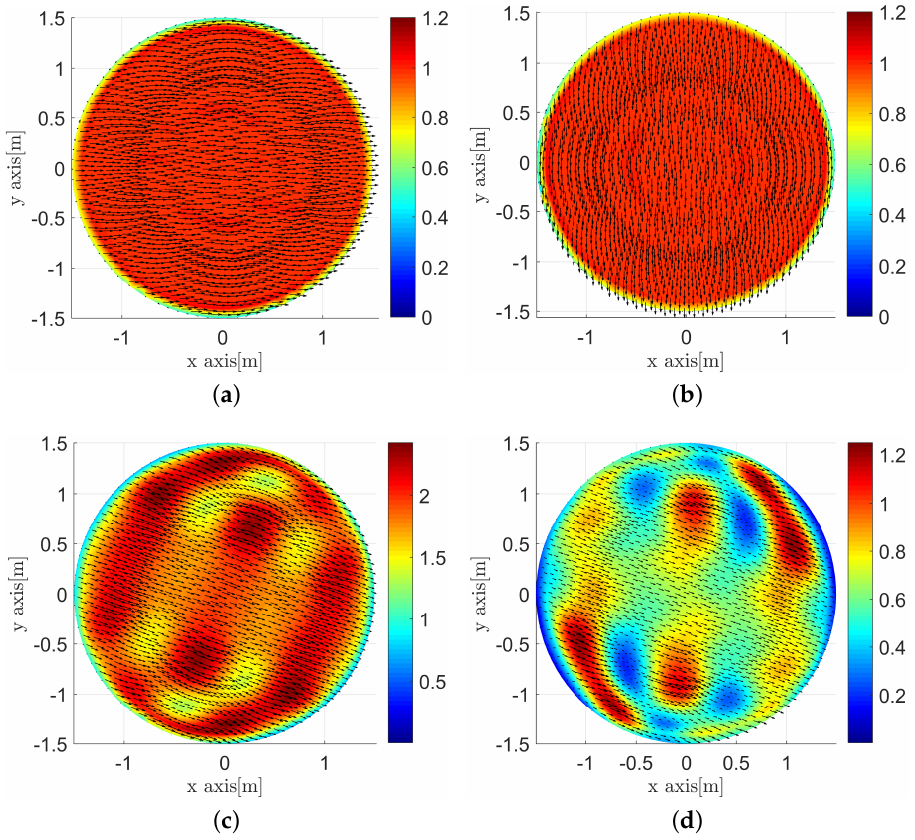
Figure 4. Surface current distributions of the SHDB disk shown in Figure 1 at the frequency of 300 MHz for an incident wave with u i = − z . ( a ) Real { η 0 J } for T d = 1, T s = 0 (DB surface). ( b ) Real { M } for T d = 1, T s = 0 (DB surface). ( c ) Real { η 0 J } for T d = 0, T s = 1 (SH surface). ( d ) Real { M } for T d = 0, T s = 1 (SH